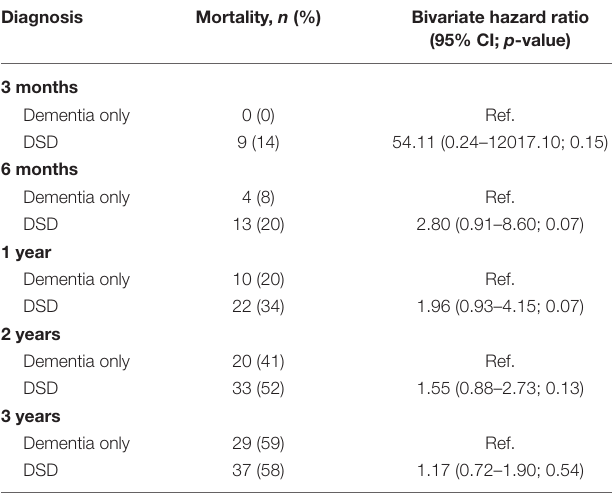
TABLE 2 | Association between diagnosis and mortality ( n = 113 patients).